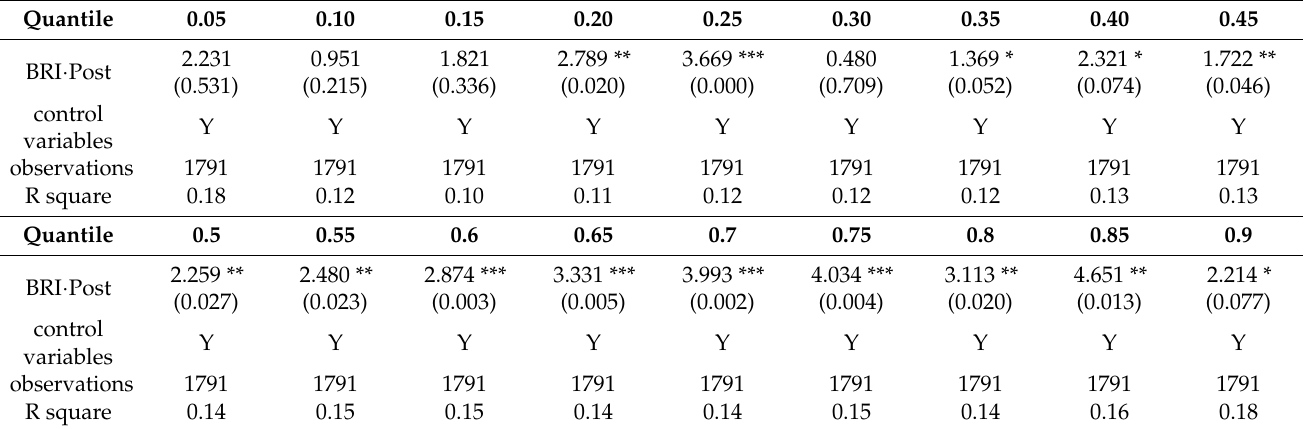
Table 2. The results of regression using the quantile